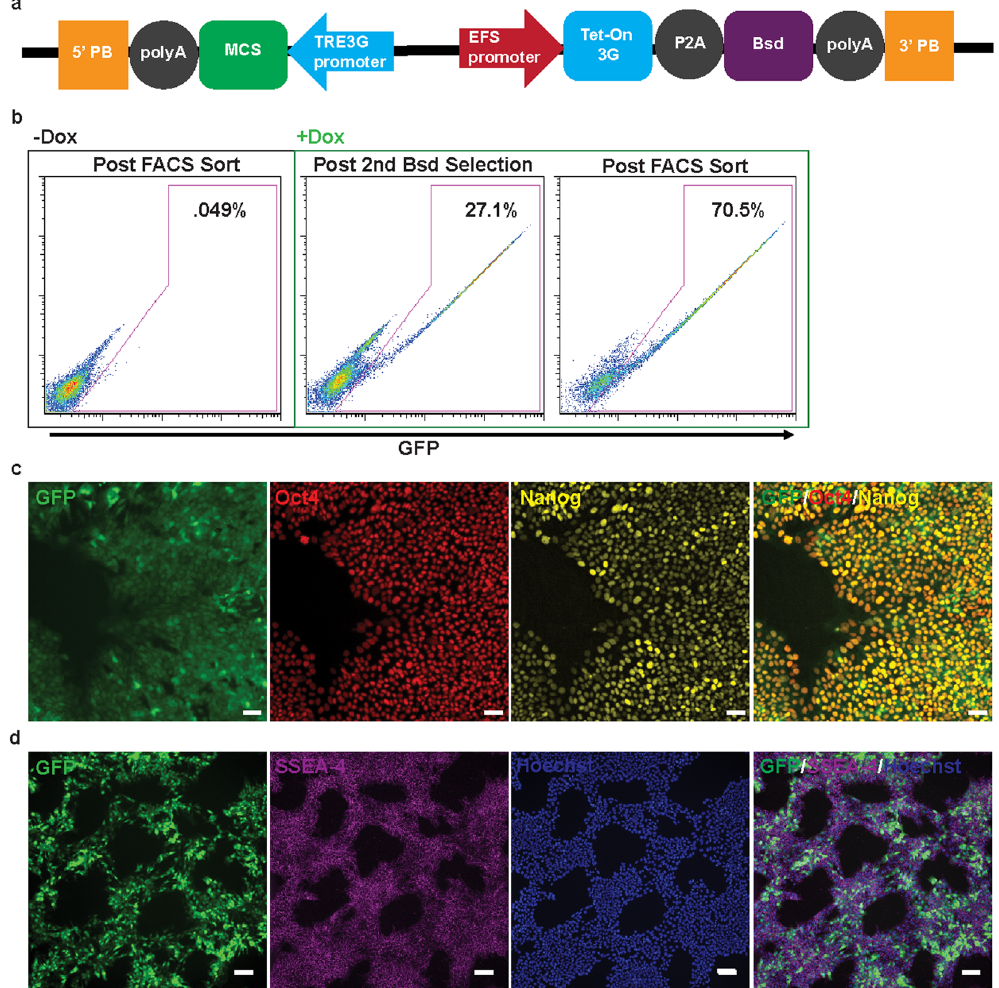
Figure 1. Design and generation of XLone transgenic hPSCs. ( a ) Schematic showing transposable plasmid cassette design. The ColE1 origin of replication and ampicillin resistance gene for E.coli amplification are not shown. 5 ′ PB, 5 ′ PiggyBac Terminal Repeat; 3’ PB, 3’ PiggyBac Terminal Repeat; MCS, Multiple Cloning Sites; Bsdr, Blasticidin resistance gene. ( b ) The tight control of gene expression (GFP) is shown to have less than 1% GFP positive cells without the addition of Dox. Flow cytometry analysis of the cells after Bsd drug selection and FACS live cell sort. Live cell sorting enriched the population to maximal 70.5% GFP positive. ( c ) GFP positive cells with immunostaining of transcription factor pluripotency markers Oct4 and Nanog. Scale bars are 50 µ m. ( d ) GFP positive cells with immunostaining of cell surface pluripotency marker SSEA-4. Scale bars are 100 µ